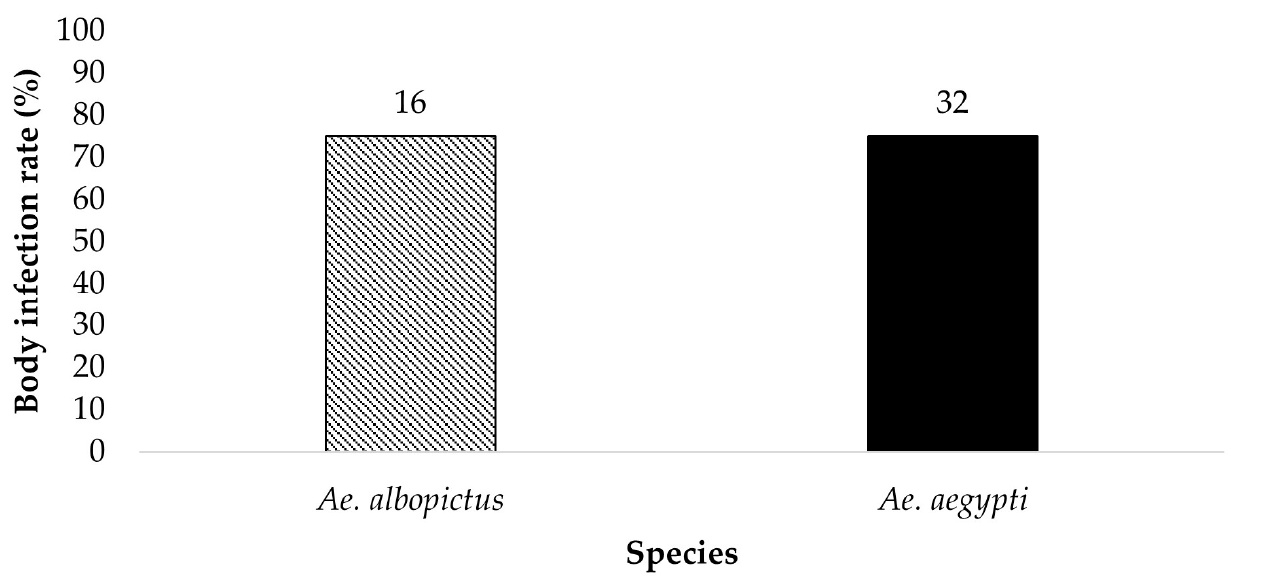
Figure 1. All bodies were tested for the presence of ZIKV infection. The results show the susceptibility to ZIKV infection of parental Ae. aegypti and Ae. albopictus from the treatment groups ingesting infected blood at a dose of 6 log 10 PFU/mL. The numbers above the bars represent the number of mosquitoes tested.